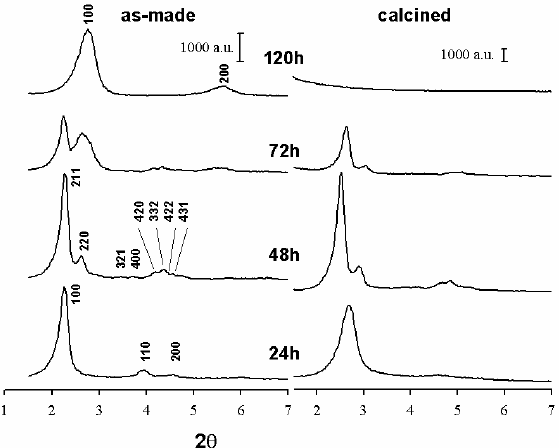
Figure 1. Small angle powder XRD patterns of as-made (left) and calcined (right) silica mesophases obtained at 130 ° C for 24, 48, 72 and 120 h reaction